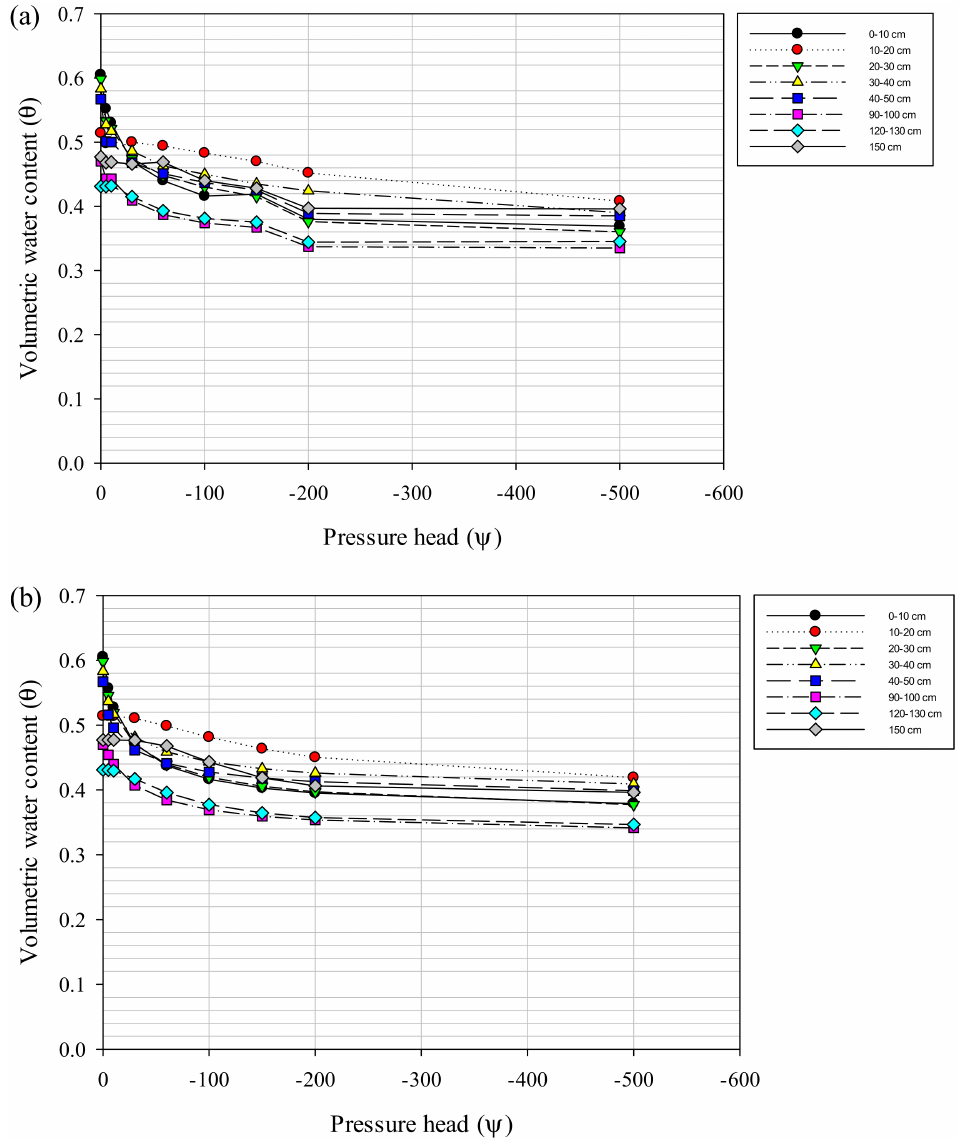
Figure 6. Water retention θ ( ψ ) curves in the virgin forest at different soil depths. ( a ) Observed θ ( ψ ). ( b ) Estimated θ ( ψ